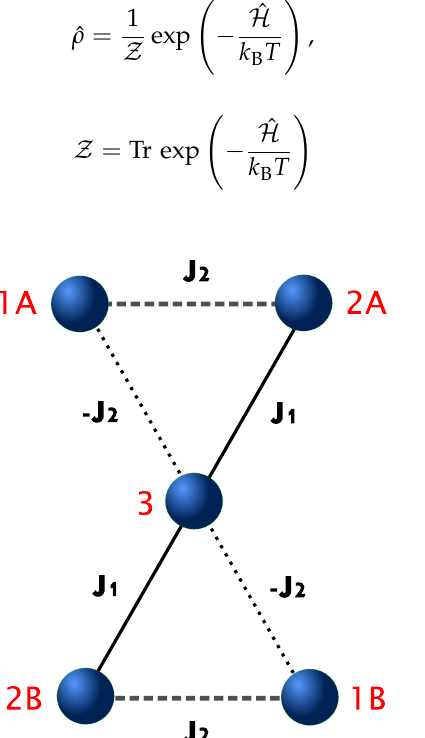
Figure 1. Schematic view of the Cu5-NIPA magnetic cluster with the relevant magnetic couplings